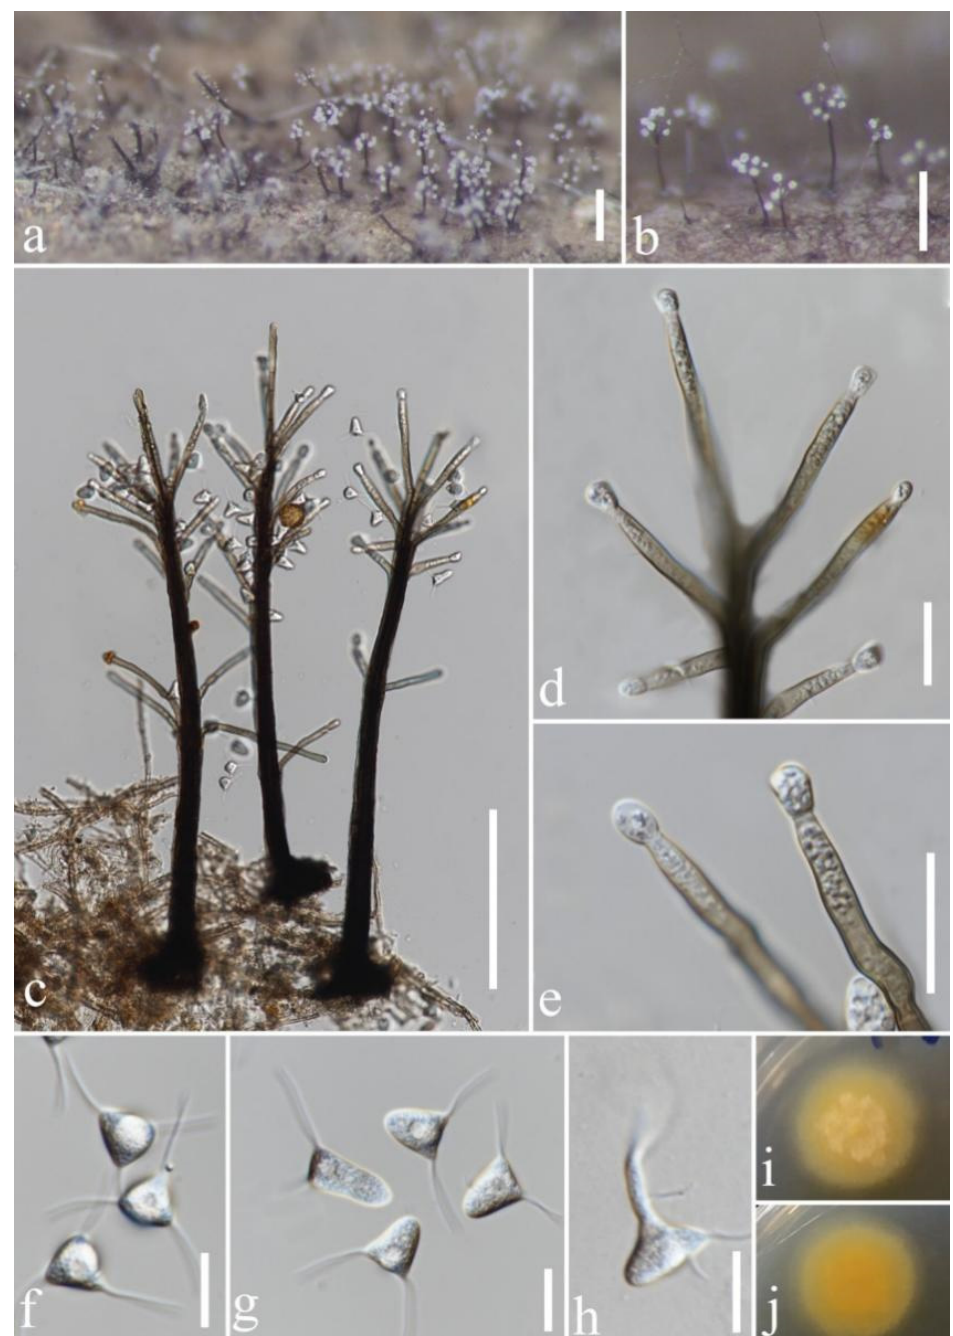
Figure 9. Phialosporostilbe scutiformis (MFLU 22-0077). ( a , b ) Colonies on woody substrate; ( c ) conid- iophores; ( d , e ) conidiogenous cells with conidia; ( f , g ) conidia; ( h ) germinated conidium; ( i , j ) culture on PDA from above and below. Scale bars: ( a , b ) 200 μ m; ( c ) 100 μ m; ( d , e ) 20 μ m; ( f – h ) 10 μ